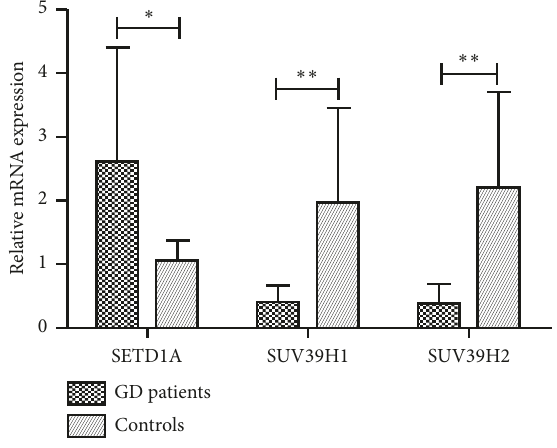
Figure 2: Relative mRNA levelsof HMTs in PBMCs of patients with GD and healthy controls. Results represent mean ± SD expression levels normalized to 𝛽 -actin. SUV39H1 and SUV39H2 mRNA expressions were significantly decreased ( ∗∗ P < 0.001), whereas the expression of SETD1A mRNA was higher in GD patients ( ∗ P=0.004).